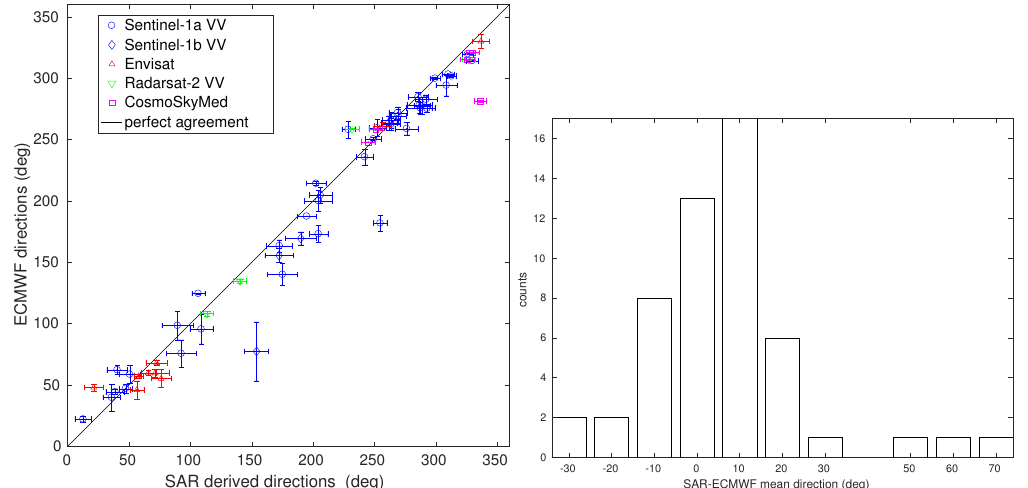
Figure 5. Comparison between SAR derived versus ECMWF wind directions for all the images. Left panel : scatter plot. The bars report the standard deviations. Solid line: perfect agreement. Right panel : SAR minus ECMWF wind direction difference